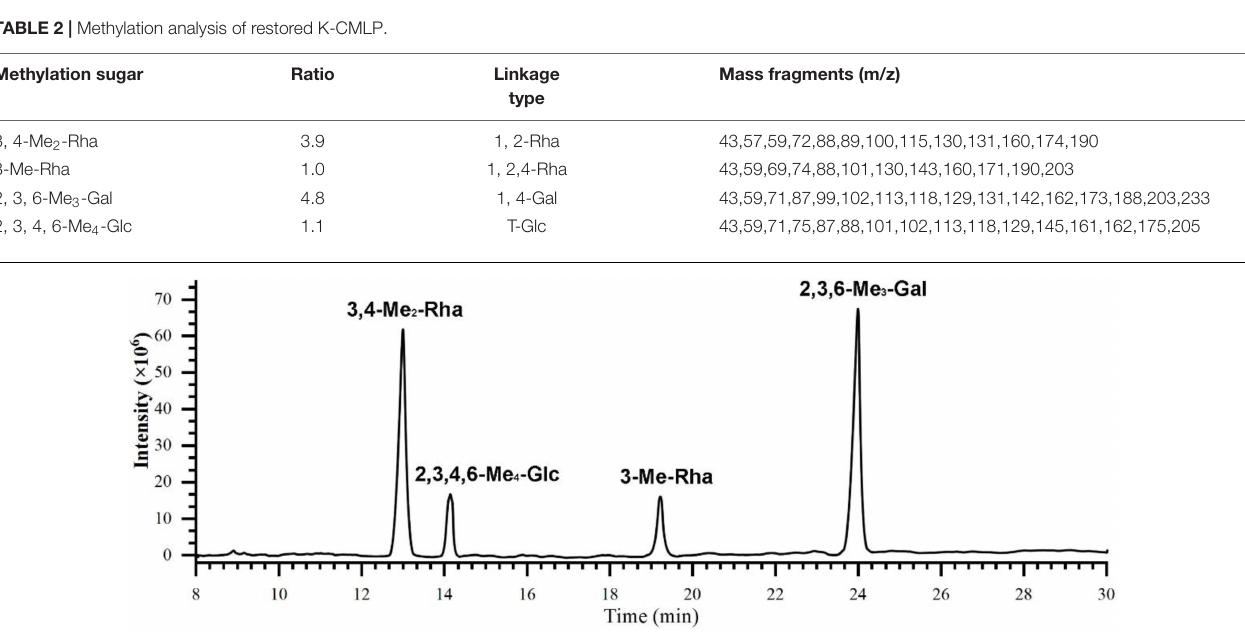
FIGURE 4 | The total ion chromatogram of K-CMLP by